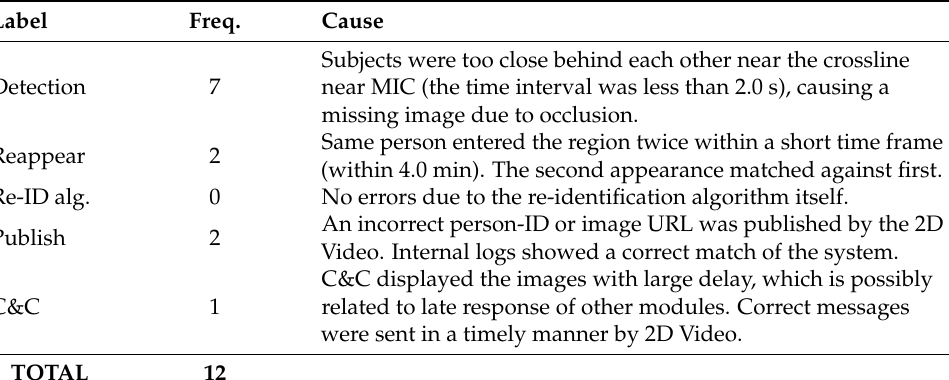
Table 3. Error causes of 2D